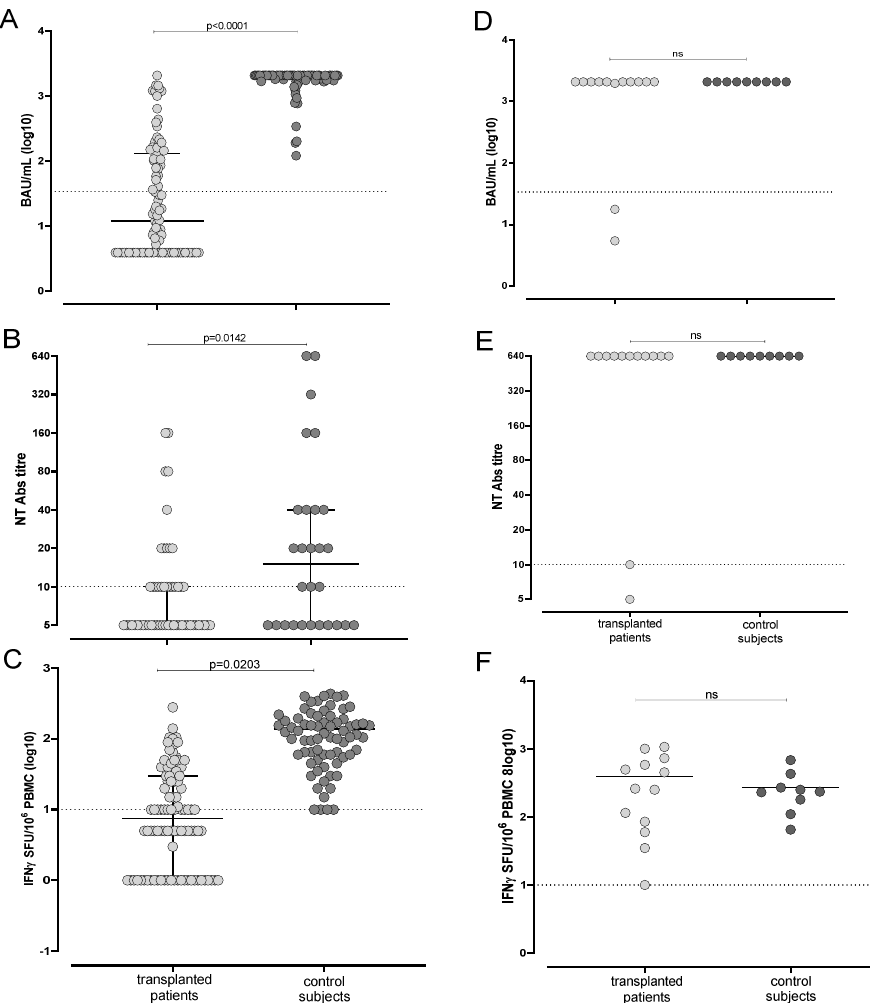
Figure 1. Total IgG SARS-CoV-2 response measured by Trimeric assay ( A ), SARS-CoV-2 NT Abs level ( B ) and Spike-specific response-cell response ( C ) were compared in SARS-CoV-2 naïve BNT162b2 vaccinated transplanted patients ( n = 97) and healthy controls ( n = 74). Total IgG SARS-CoV-2 response measured by Trimeric assay ( D ), SARS-CoV-2 NT Abs level ( E ) and Spike-specific response-cell response ( F ) were compared in SARS-CoV-2 recovered BNT162b2 vaccinated transplanted patients ( n = 13) and healthy controls ( n = 9). p values were obtained by Mann–Whitney test and given for each graph.